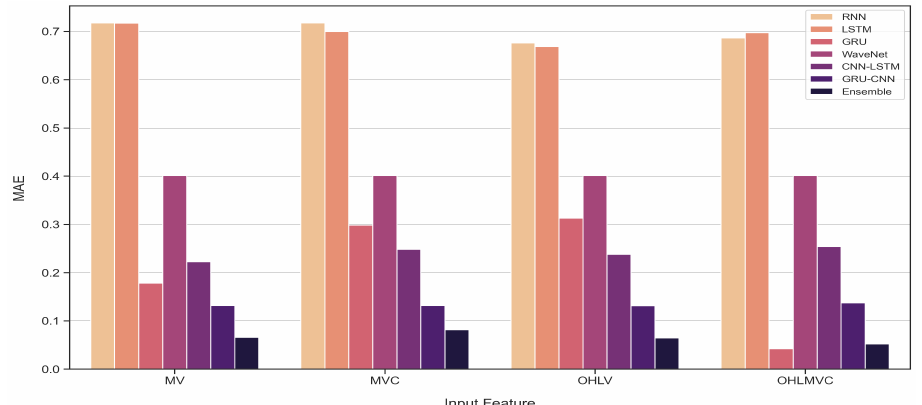
Figure 18. Comparison of the average MAE of all models using MV, MVC, OHLV, and